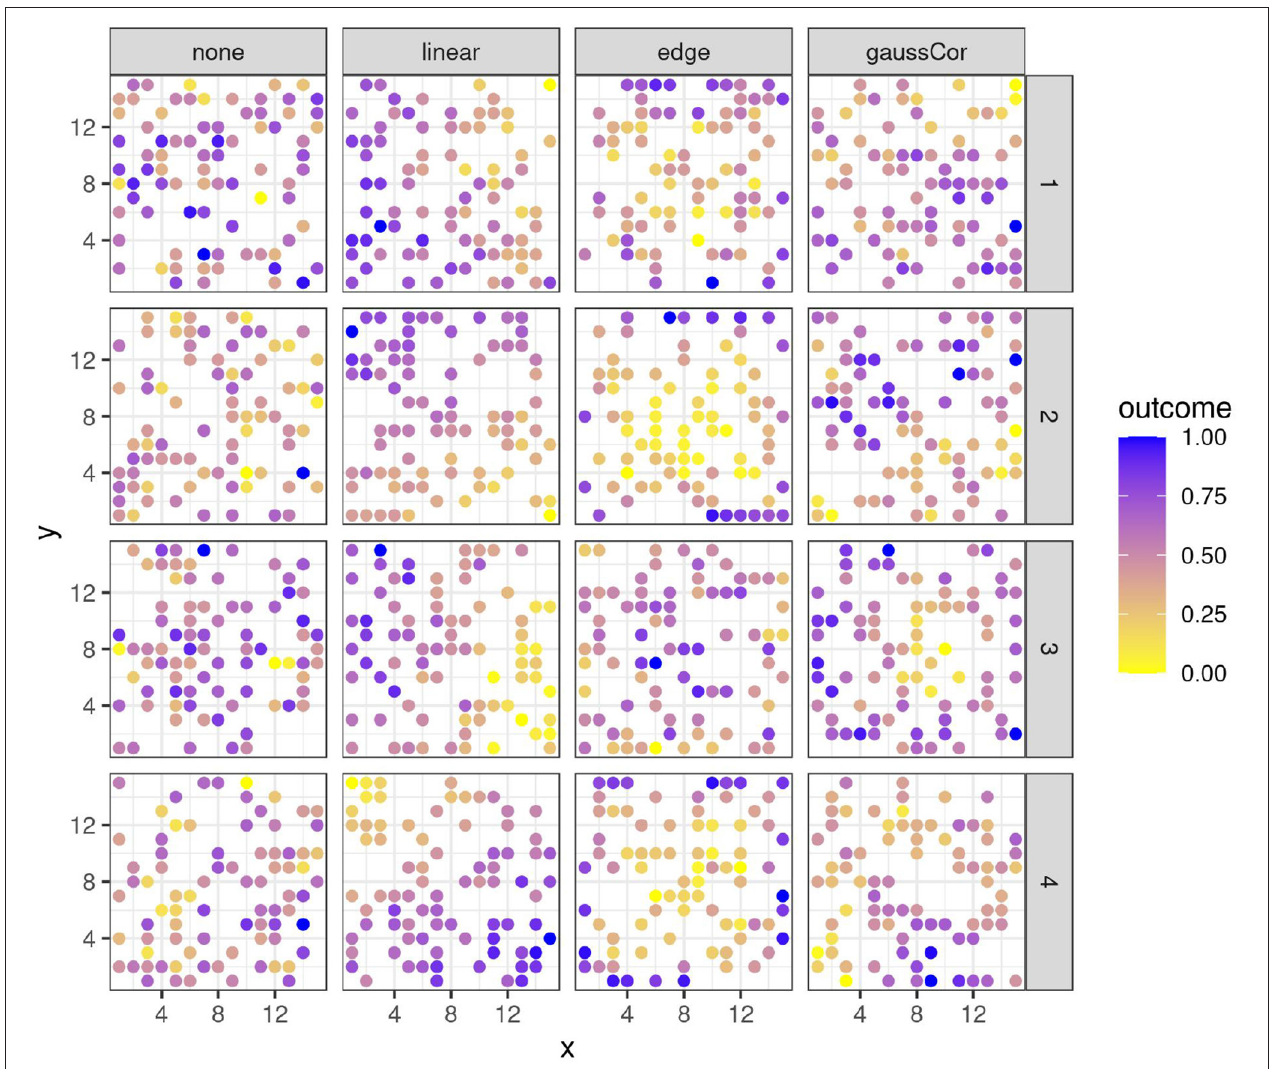
FIGURE 1 | Four instances (rows) of variables with different spatial structures (columns). x- and y-axes represent spatial coordinates. Colors reflect the value of the outcome variable, scaled to the 0-1 range for legibility.